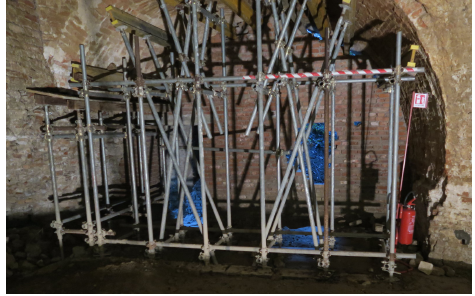
Figure 10. Final part of bastion left